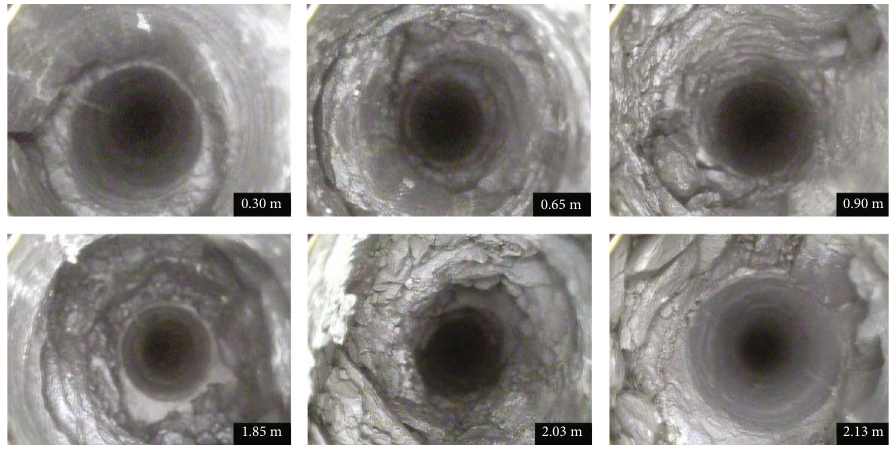
Figure 7: Endoscopic research results of roadway roof